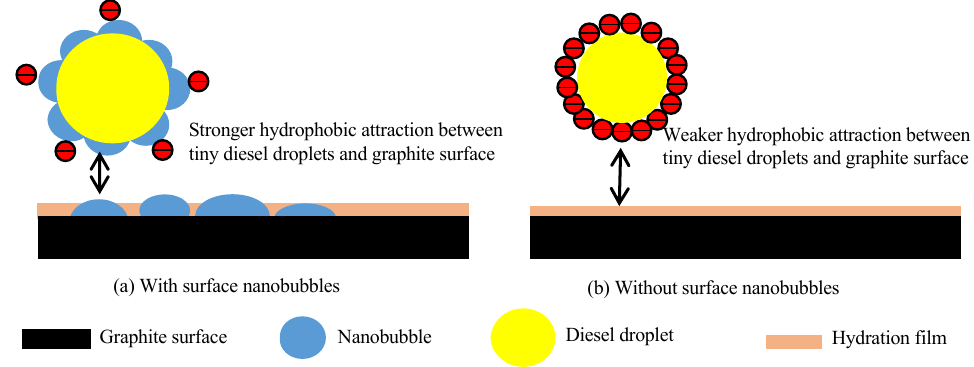
Figure 12. Illustration of hydrophobic attraction between graphite and diesel droplets with ( a ) and without nanobubbles ( b ).